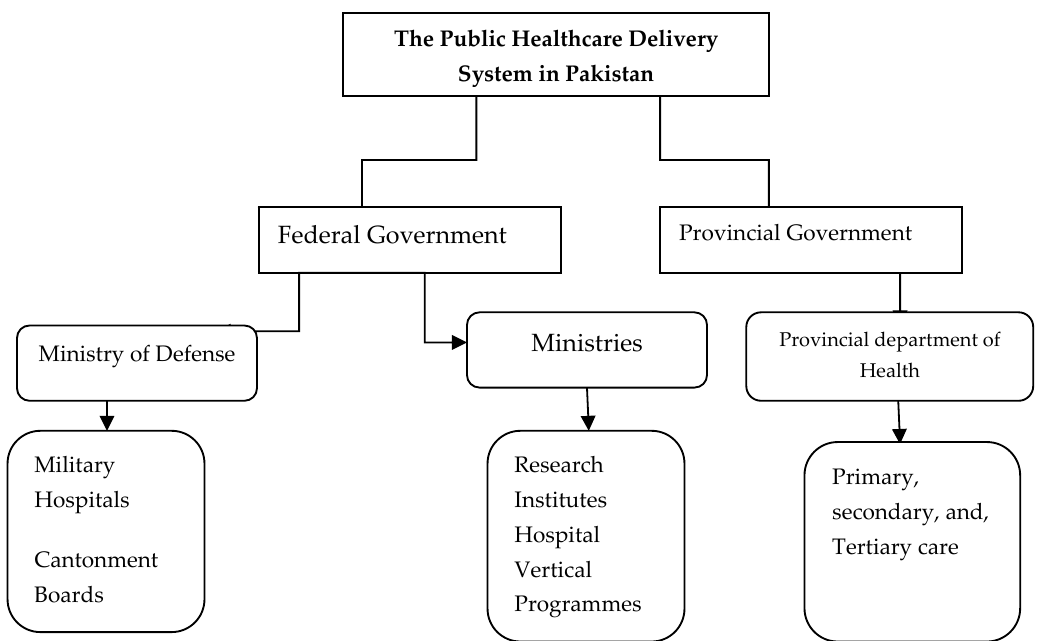
Figure 1. The public healthcare delivery system in Pakistan.